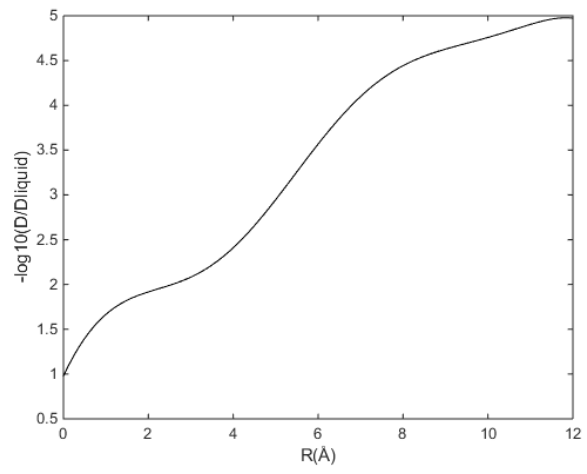
Figure 2. Relative diffusivities of CO 2 across the interface from liquid water side to hydrate interface side.